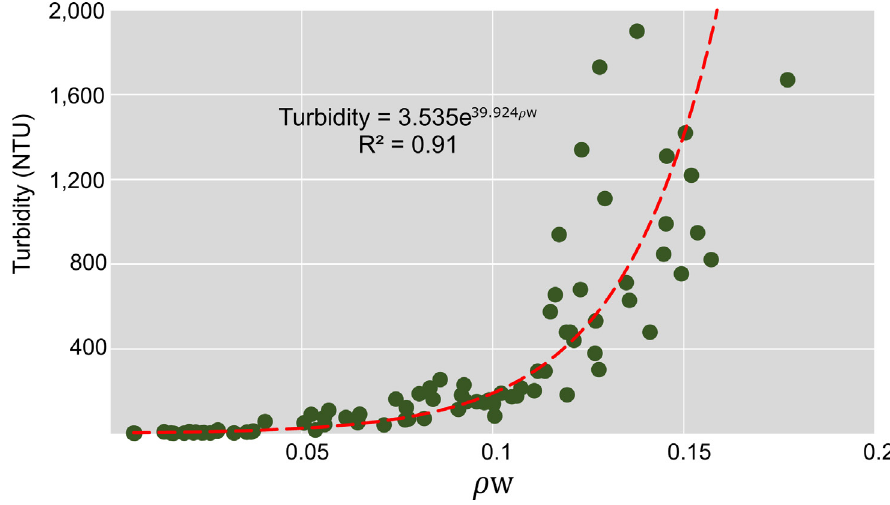
Figure 6. Dispersion graph of the reflectance from one infrared band of Sentinel-2 (band 8) and turbidity values (green points) with the exponential model (red line). The deviation of the observed values from the model curve increases as the turbidity